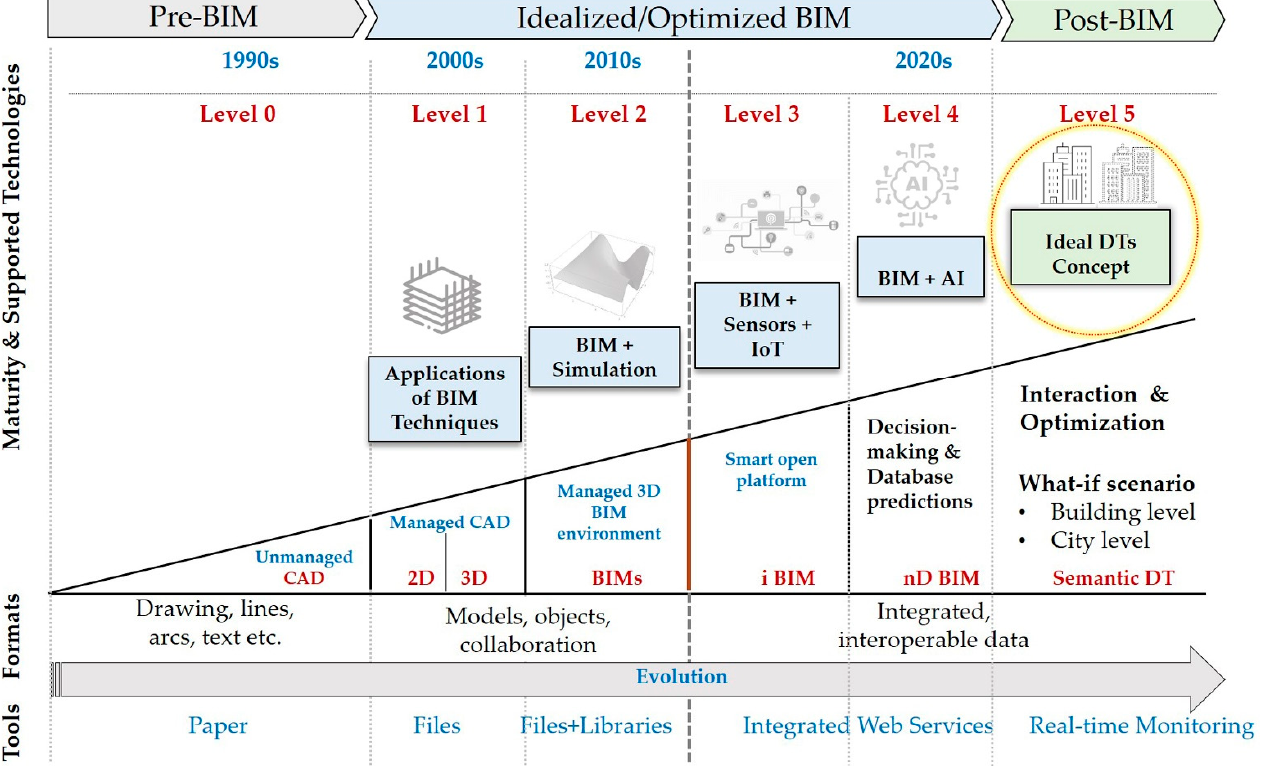
Figure 6. BIM and DTs processes and supporting technologies. Adapted from [61].